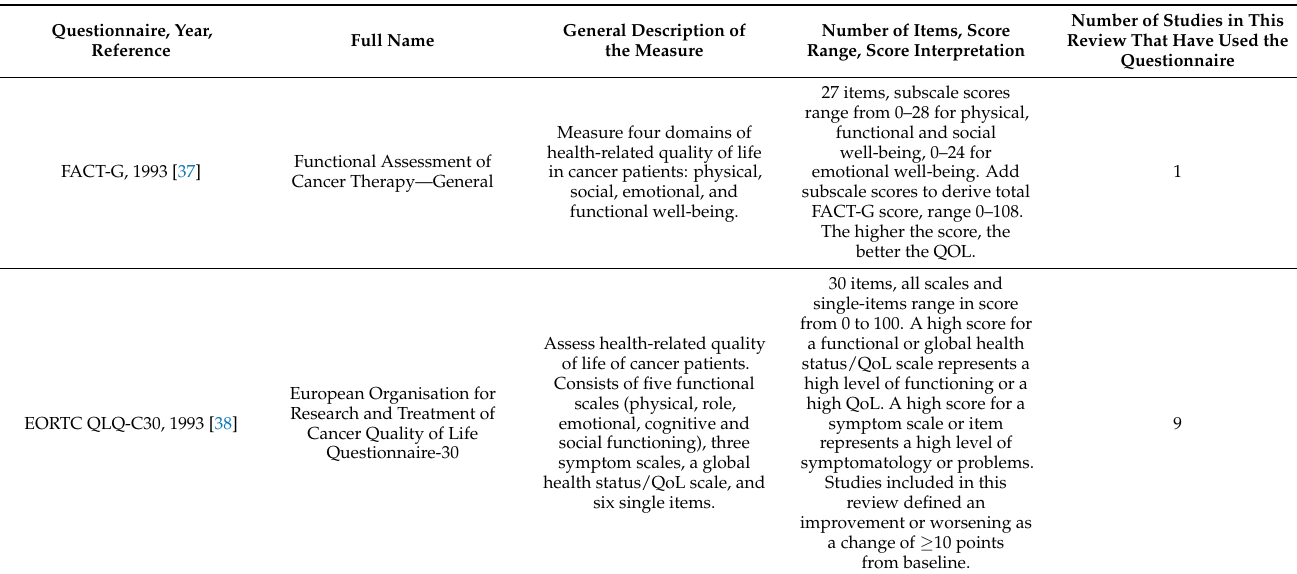
Table 2. Characteristics of the frequently used